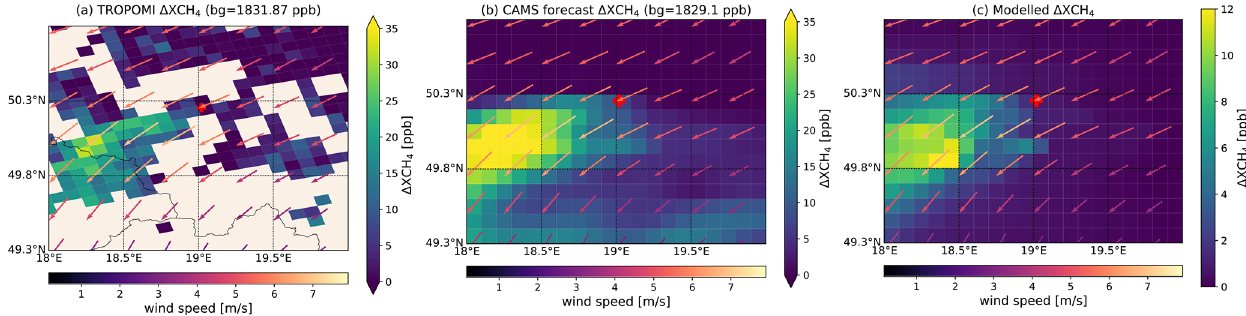
Figure 6. (cid:49) XCH 4 together with the ERA5 wind at 12:00UTC from (a) TROPOMI observations at 11:34UTC, (b) CAMS forecast at 12:00UTC, and (c) from the simple cone plume model (averaged over the daytime) based on the CAMS-GLOB-ANT inventory over the USCB region on an example day (6 June 2018). The “bg” in the title of (a) and (b) represents the average background, derived from the mean XCH 4 in the upwind region (50.3–50.8 ◦ N, 19.5–20.0 ◦ E). Note that a different color bar has been used in panel (c) for improved